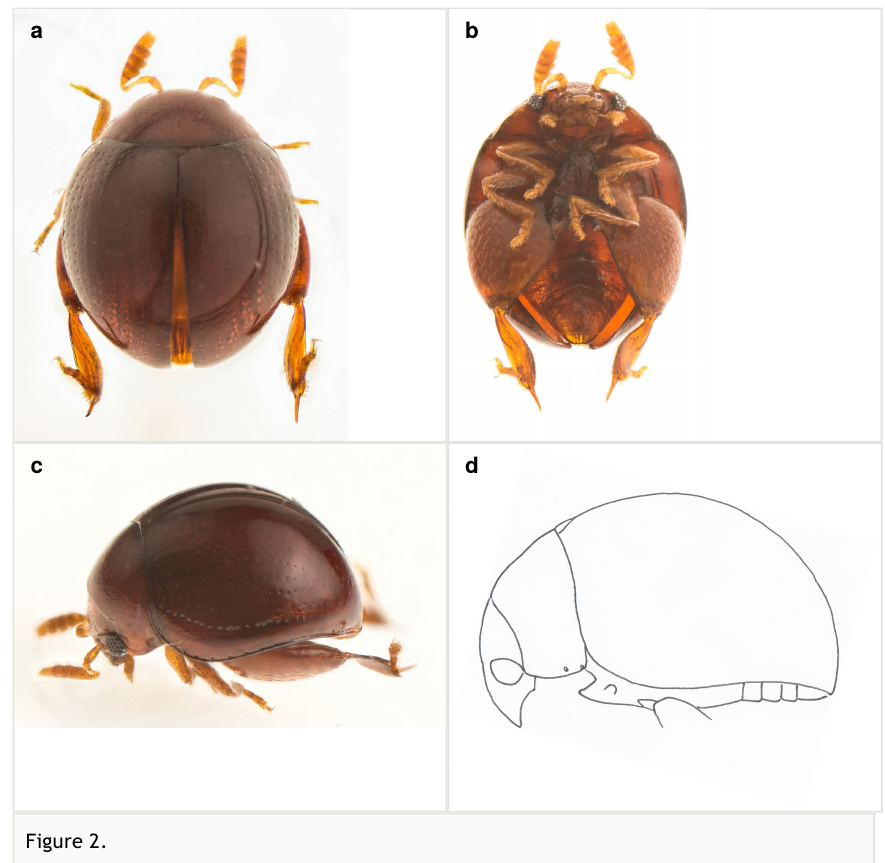
Figure 2. Clavicornaltica belalongensis n. sp., external morphology, female (paratype, UBDM.3.01173). a : dorsal